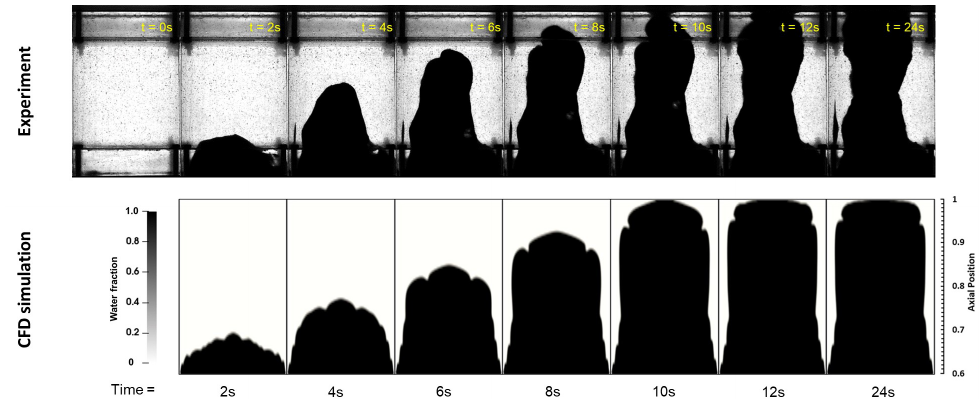
Figure 8. Updated CFD simulation ( bottom ) of interface evolution of water displacing 0.225 wt.% xanthan gum solution with induced perturbations at the initial